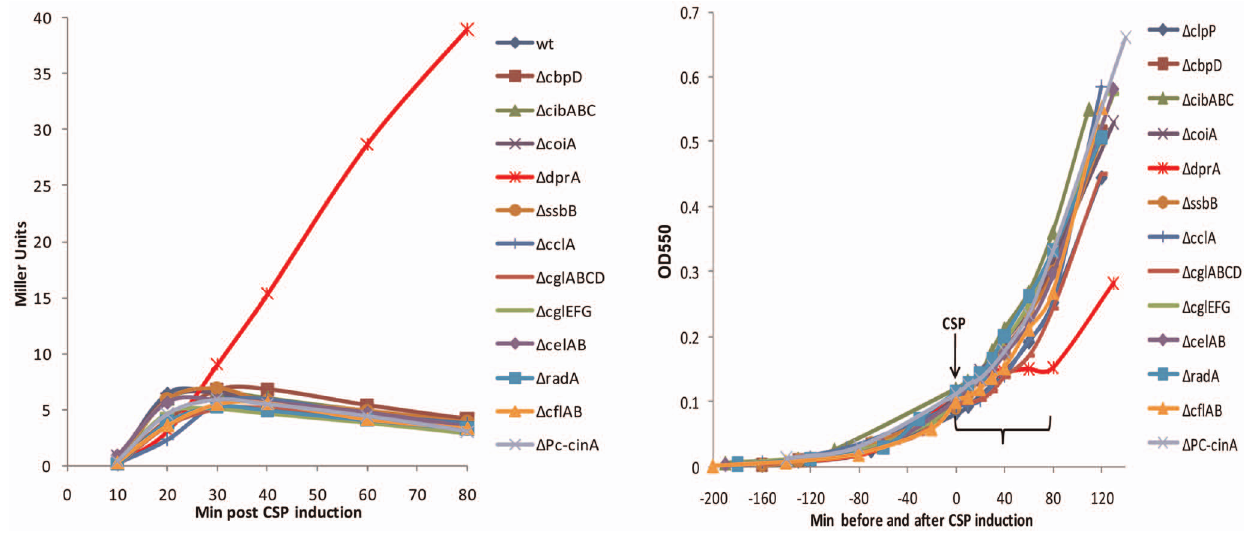
Figure 3. Survey of effect of late gene mutations on exit from the competent state in the protease deficient D clpP background. A. After CSP induction, late gene expression patterns were monitored in wild type and late gene mutants in D clpP background. The lacZ reporter and the measurement of b -galactosidase activity were done as described for Figure 2. Each strain is indicated by its mutant competence gene as listed in Table 1. B. Growth patterns monitored as culture optical density at 550 nm before and after CSP treatment. Bracket indicates period of LacZ assay shown in panel A.